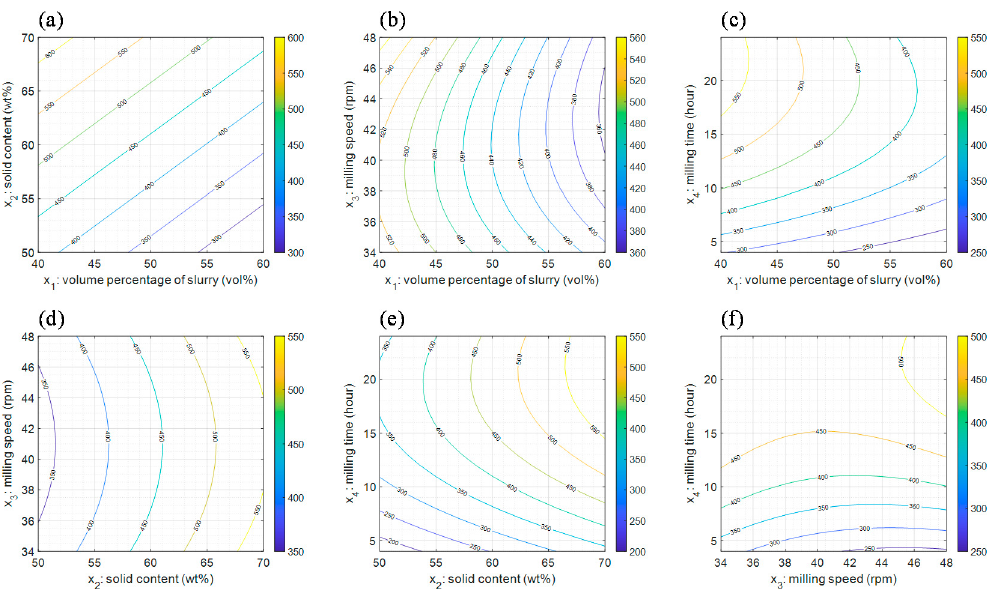
Figure 9. Contour plots for Equation (9): ( a ) ( x 1 , x 2 ); ( b ) ( x 1 , x 3 ); ( c ) ( x 1 , x 4 ); ( d ) ( x 2 , x 3 ); ( e ) ( x 2 , x 4 ); ( f ) ( x 3 , x 4 ).